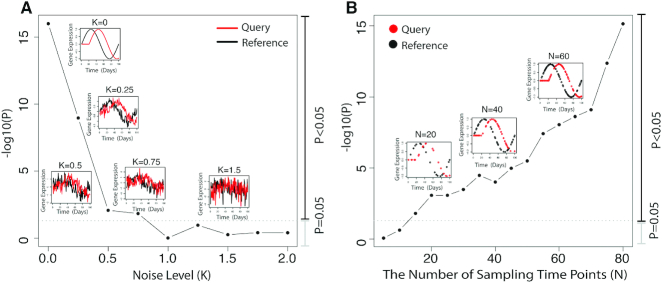
Simulation study of how the data noise and sampling density will affect P-values in TimeMeter. The query and the reference have a time shift pattern (simulated discrete time series data). (A) Increasing the noise level will decrease the power to detect the pattern associations. (B) A higher sampling density will increase the power to detect the pattern associations.